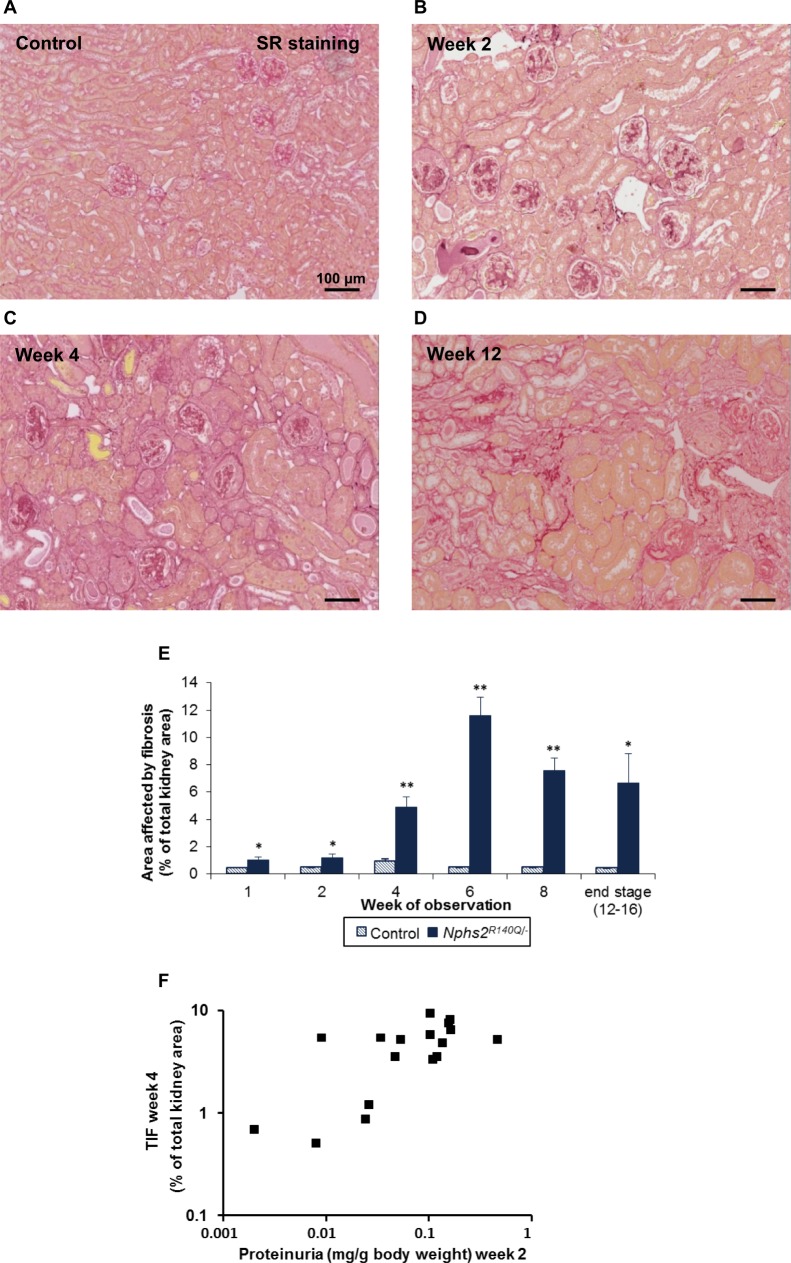
Podocin loss leads to renal damage.(A) control, (B) week 2, (C) week 4, (D) week 12. (E) Percentage of total kidney area affected by fibrosis in Nphs2R140Q/- mice increased with observation time (columns represent 4–10 animals per group and time point). (F) Proteinuria 2 weeks after induction is correlated with the tubulointerstitial fibrosis score at week 4 (n = 17; p = 0.01). SR staining; Magnification, X150. * p<0.05, ** p<0.001.